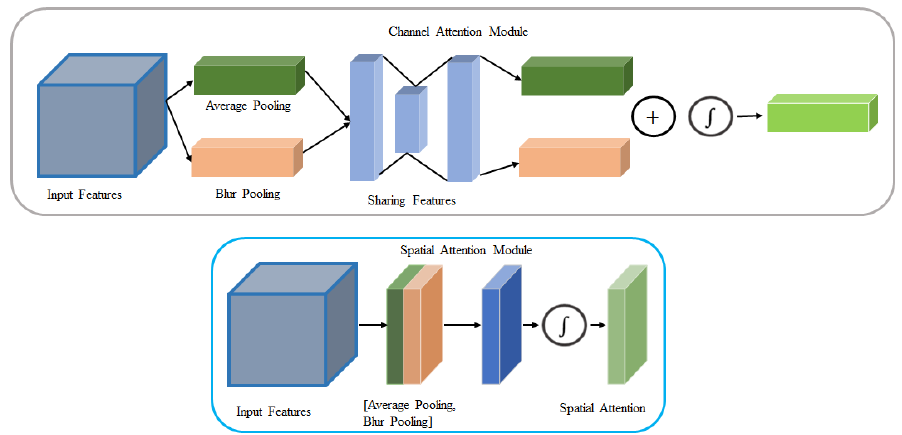
Figure 5. The architecture of the blur attention